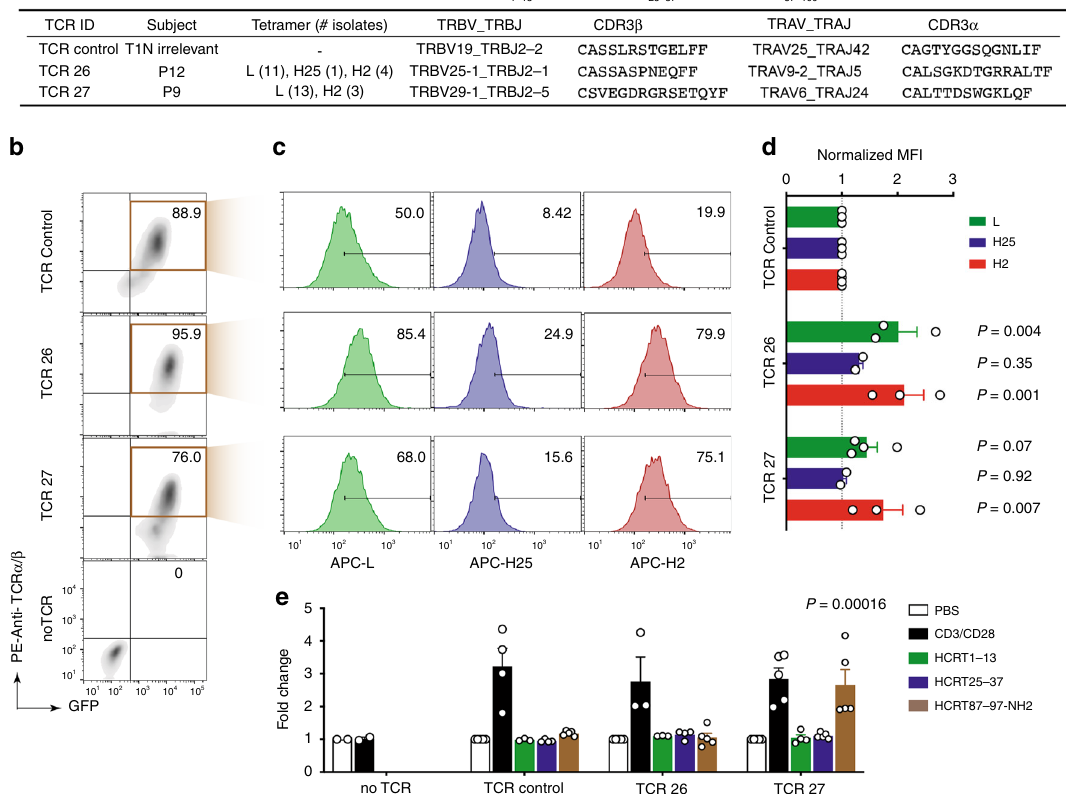
Fig. 6 Validation of tetramer binding and TCR signaling. a TCRs tested by transfection into Jurkat-luciferase reporter system 24 . b Dot-plots of Jurkat transfectants expressing TCRs as shown in a . Expression of GFP indicates a successful transfection of plasmids directing the expression of TCRs. c Tetramer staining of TCR + Jurkat cells with percentages of tetramer + cells indicated. d MFIs of the tetramer-associated signal on the surface of TCR + cells are compared. e Jurkat cells expressing the indicated TCR were incubated with DQ6-expressing APCs (HLA class II - K562 cells transfected with DQ6) in the presence of HCRT peptides or control stimuli: PBS (negative) or anti-CD3/anti-CD28 Abs (positive). Luciferase activity re fl ecting TCR-mediated signaling was measured and analyzed as previously described 24 . The bar chart shows mean ± SEM, with the corresponding data points overlaid. Signi fi cance ( P < 0.05, bolded) is determined using t -test comparing the indicated TCR and the TCR